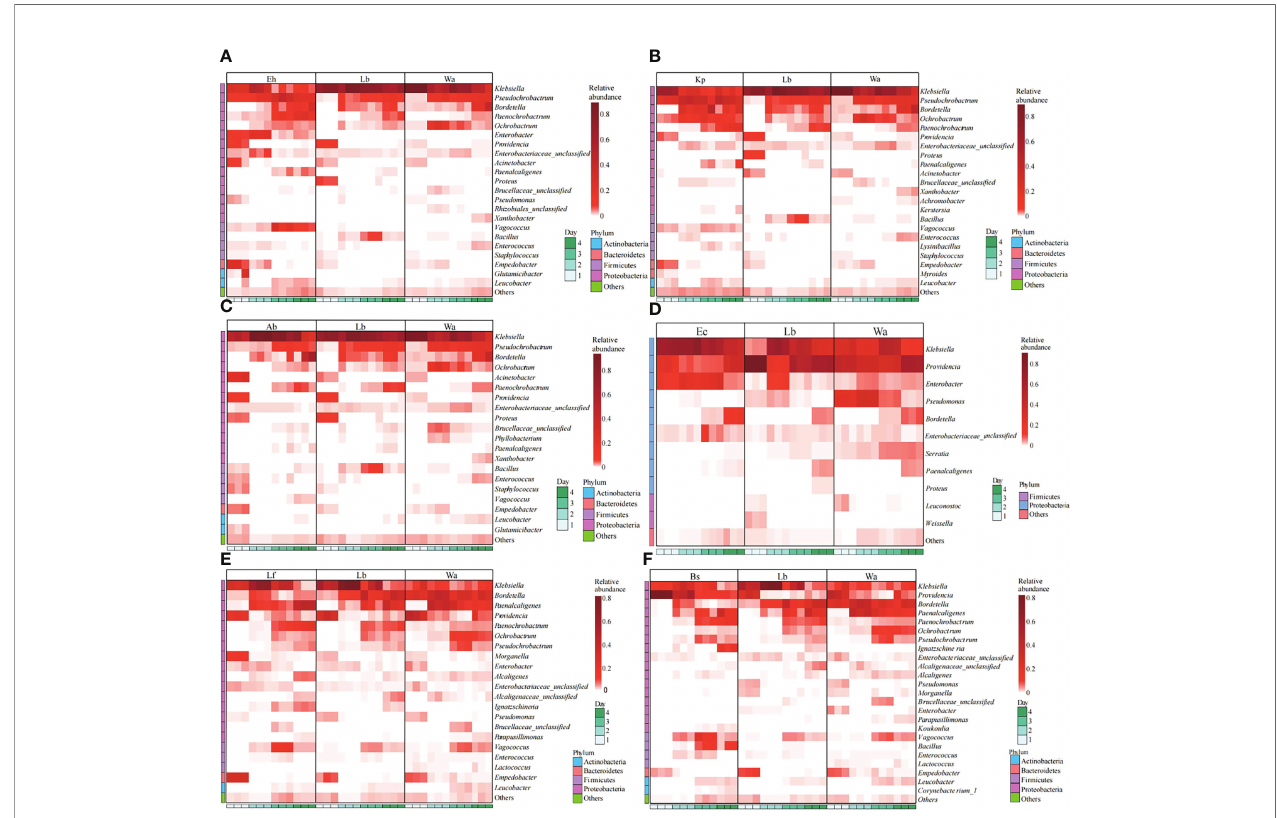
FIGURE 4 | Effects of “ bene fi cial bacteria ” in the guts of house fl y larvae on the composition of gut fl ora of larvae. Eh, Enterobacter hormaechei ; Ec, Enterobacter cloacae ; Bs, Bacillus safensis ; Lf: Lysinibacillus fusiformis ; Ab, Acinetobacter bereziniae ; Kp, Klebsiella pneumoniae . Wa, sterile water, blank control group; Lb, Luria-Bertani liquid medium, negative control group; Day 1, Day 2, Day 3, Day 4: the developmental period of house fl y